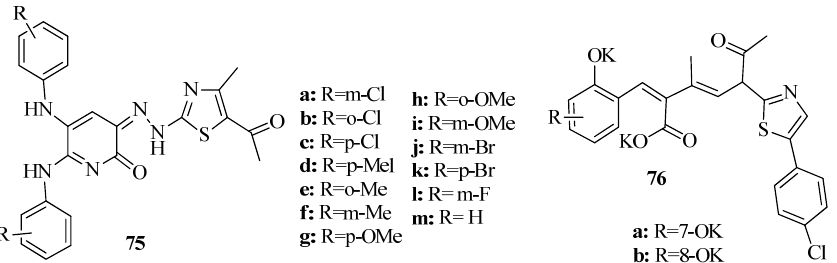
Figure 29. Structures of pyridinethiazole hybrids and 5-(4-chlorophenyl)-2-[(7/8-hydroxycoumarin -3-ylethylidene)acetylhydrazine]-1,3-thiazoles. Compounds 75a , 75b , and 75c with IC 50 values between 8.17 and 10.59 μΜ against